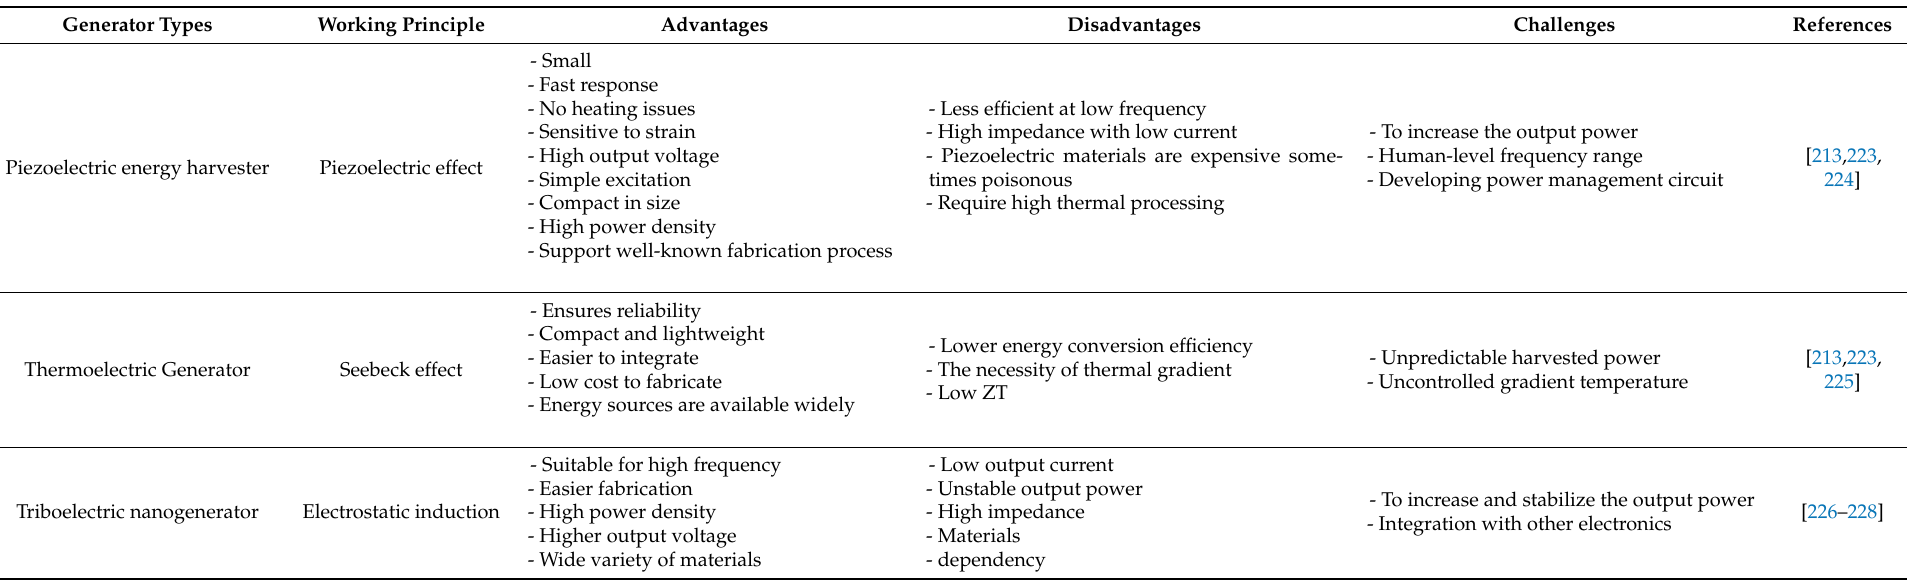
Table 8. Different techniques and its